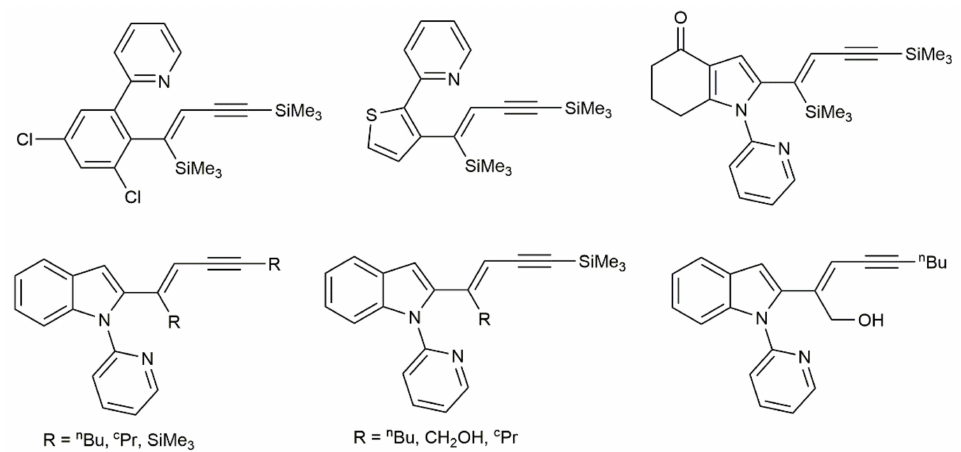
Figure 3. Selected products generated by [MnBr(CO) 5 ]-catalyzed hydrorarylation of 1,3-diynes with arenes and